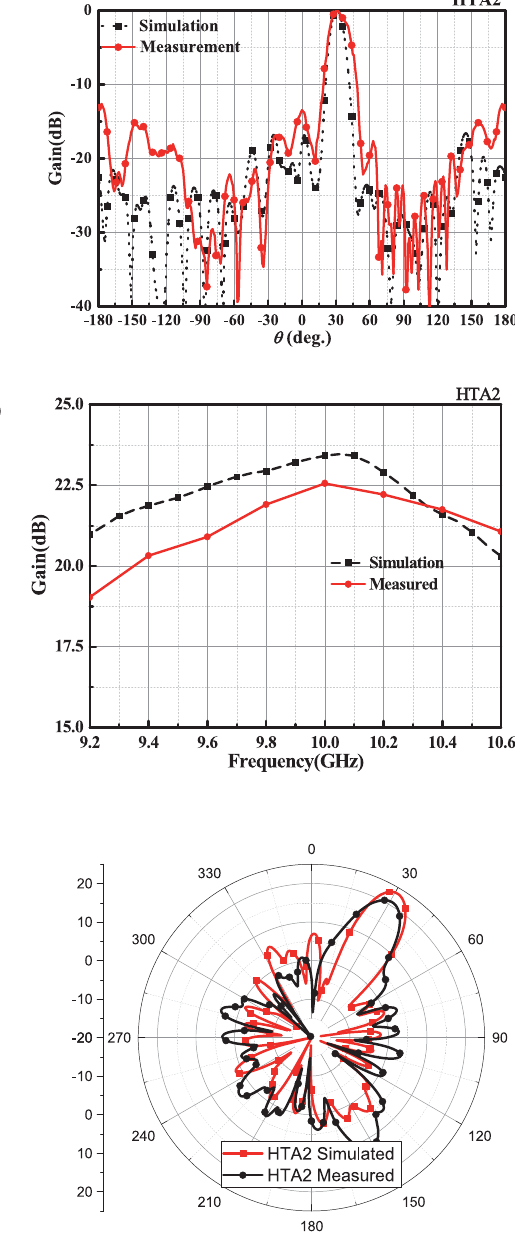
Fig. 16. Comparison of measured results and simulated result of HTA2, (a) normalized radiation pattern, (b) gain characteristics versus frequency, and (c) realized gain